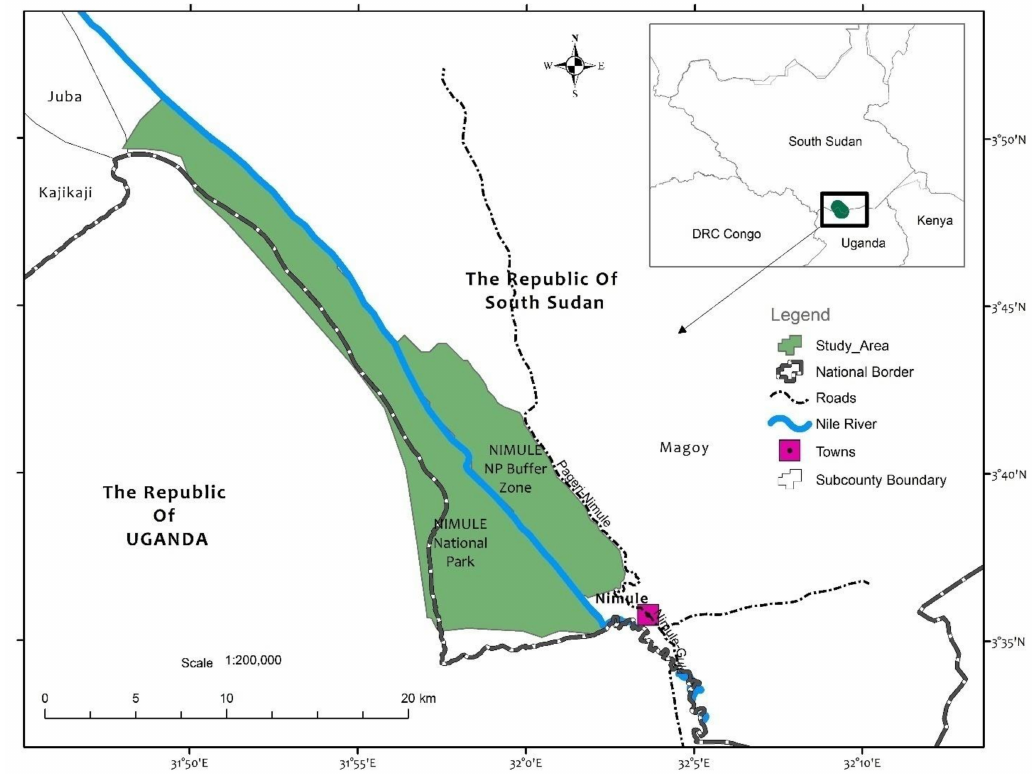
Figure 1. Map showing the location of Nimule National Park (South